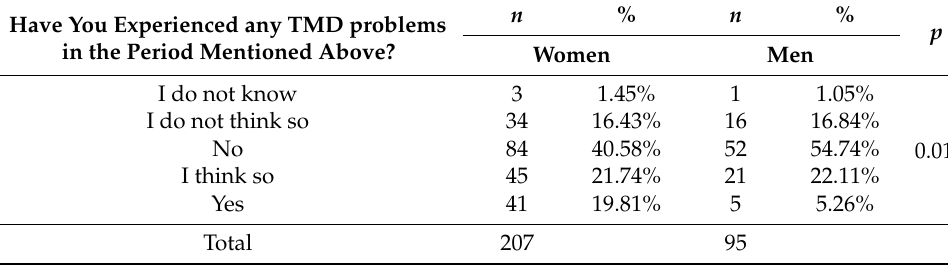
Table 11. Association between TMDs and